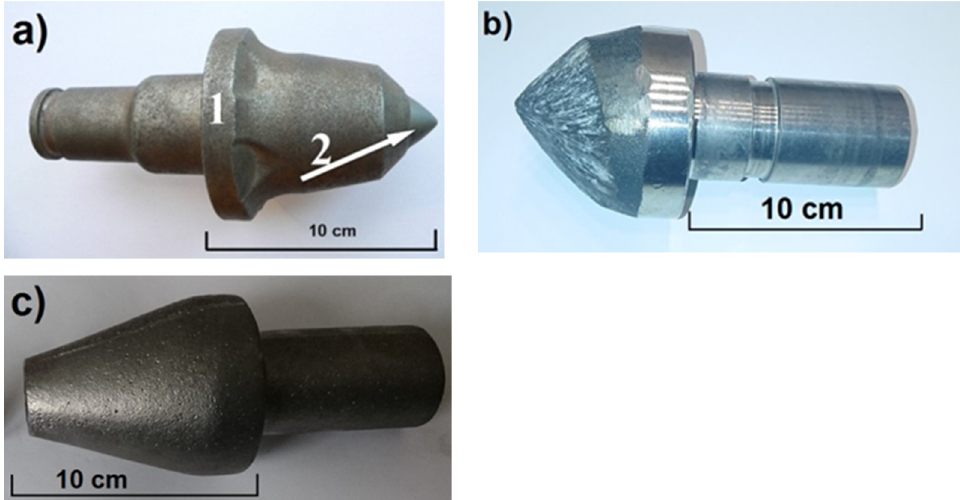
Figure 1. Practical example of conversion to casting technology: ( a ) forged shank, ( 1 ) part of shank made as forging, and ( 2 ) notch made by powder metallurgy; ( b ) worn out tool; and ( c ) cast shank [author].